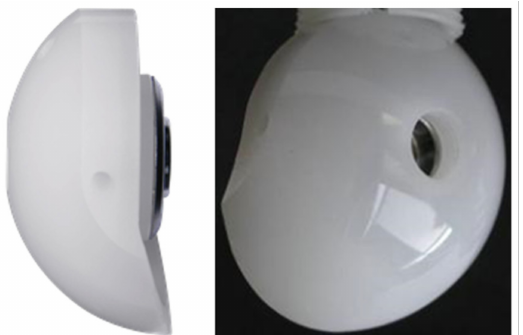
Figure 2. SMR reverse HP glenosphere (LimaCorporate S.p.A, 33038 Villanova di San Daniele del Friuli, Udine,